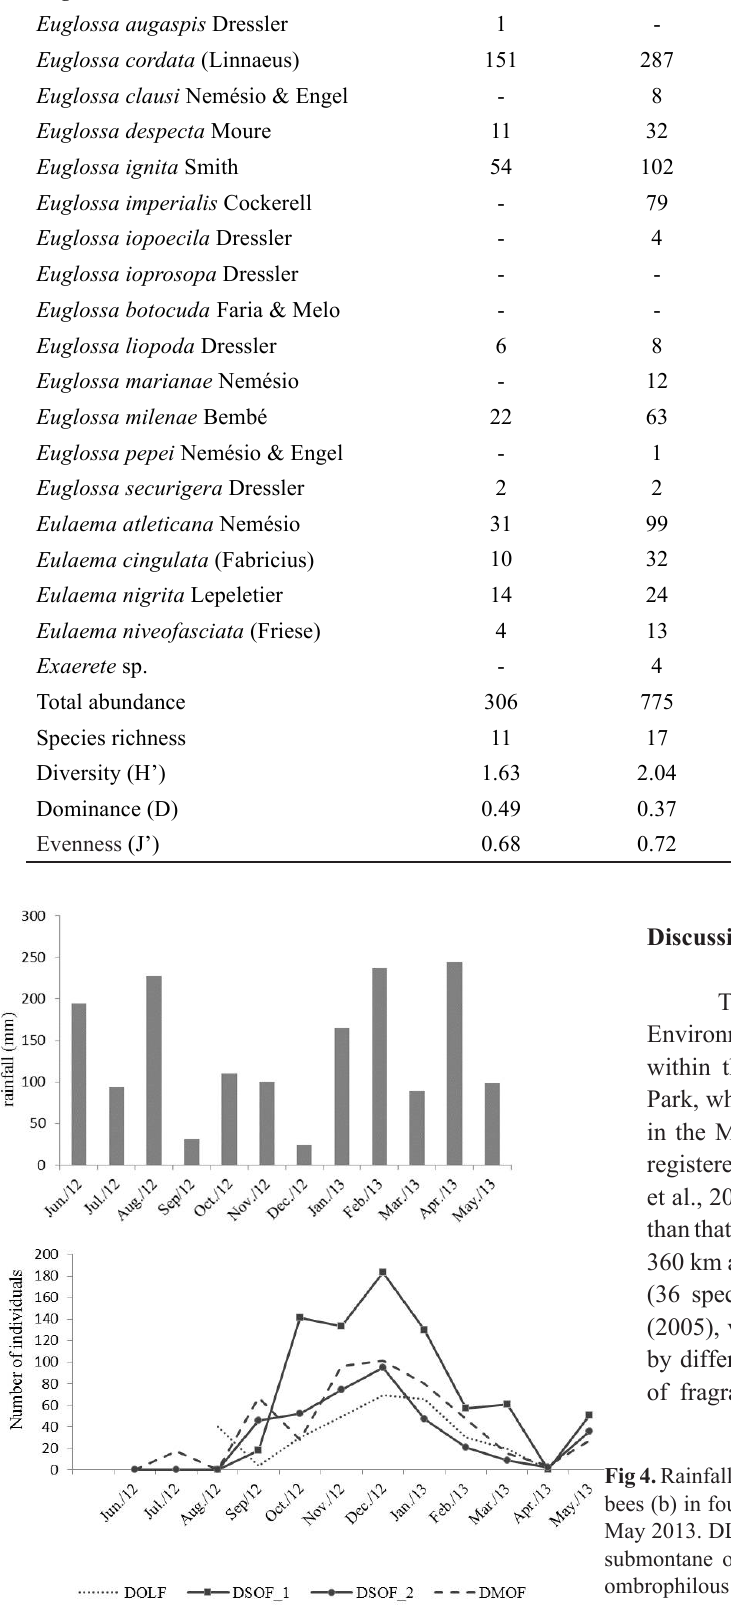
Euglossa ignita Smith